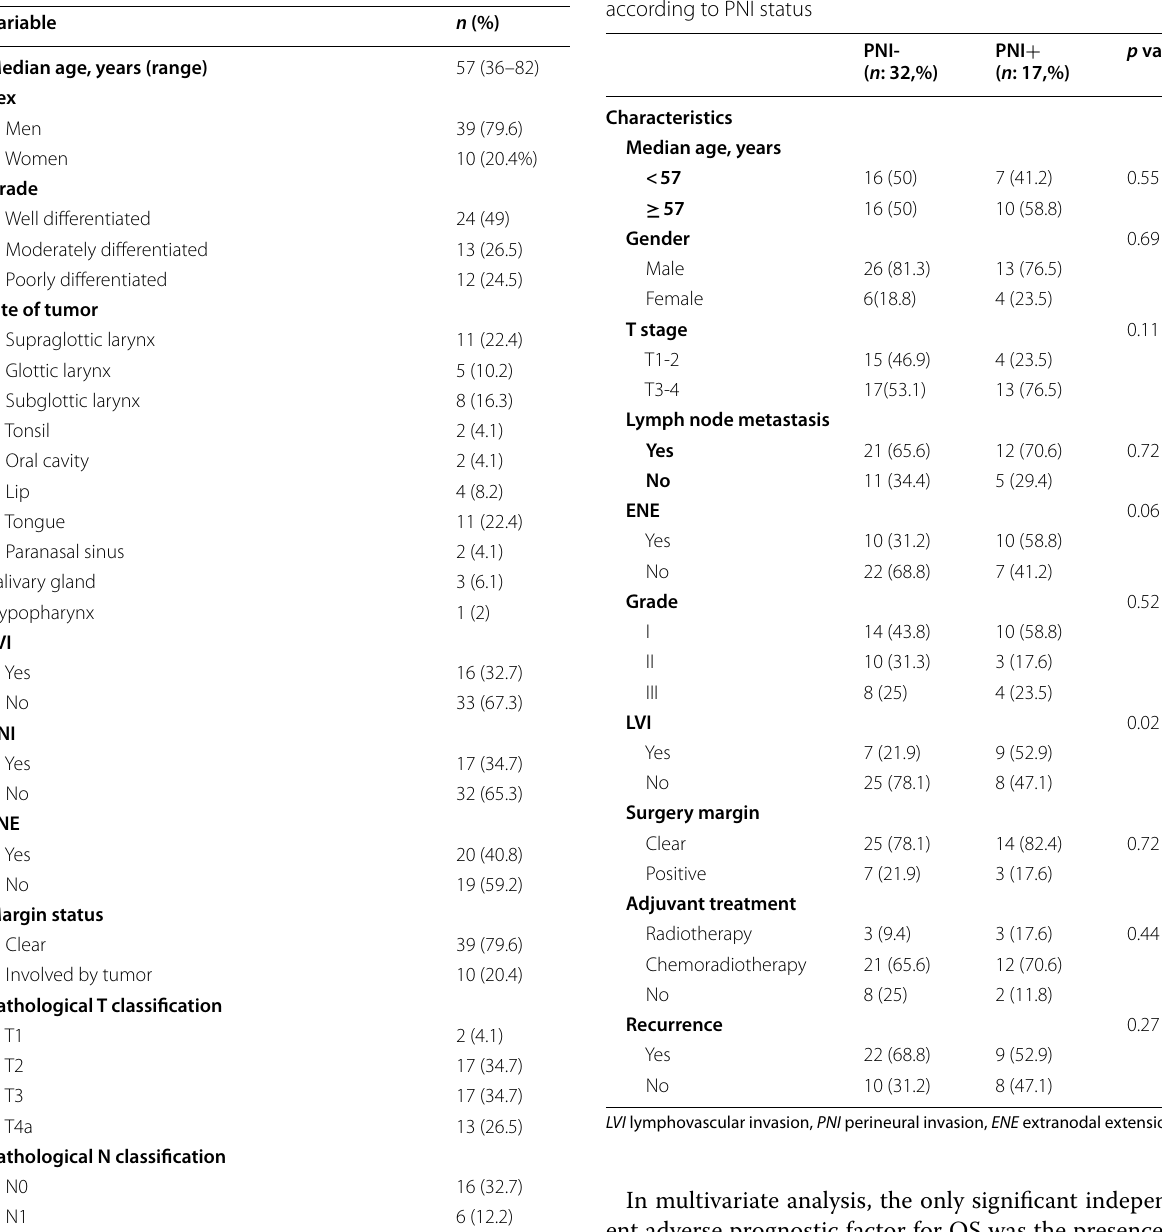
Table 1 Clinicopathological characteristics of all patients Table 2 Demographic and disease characteristics of